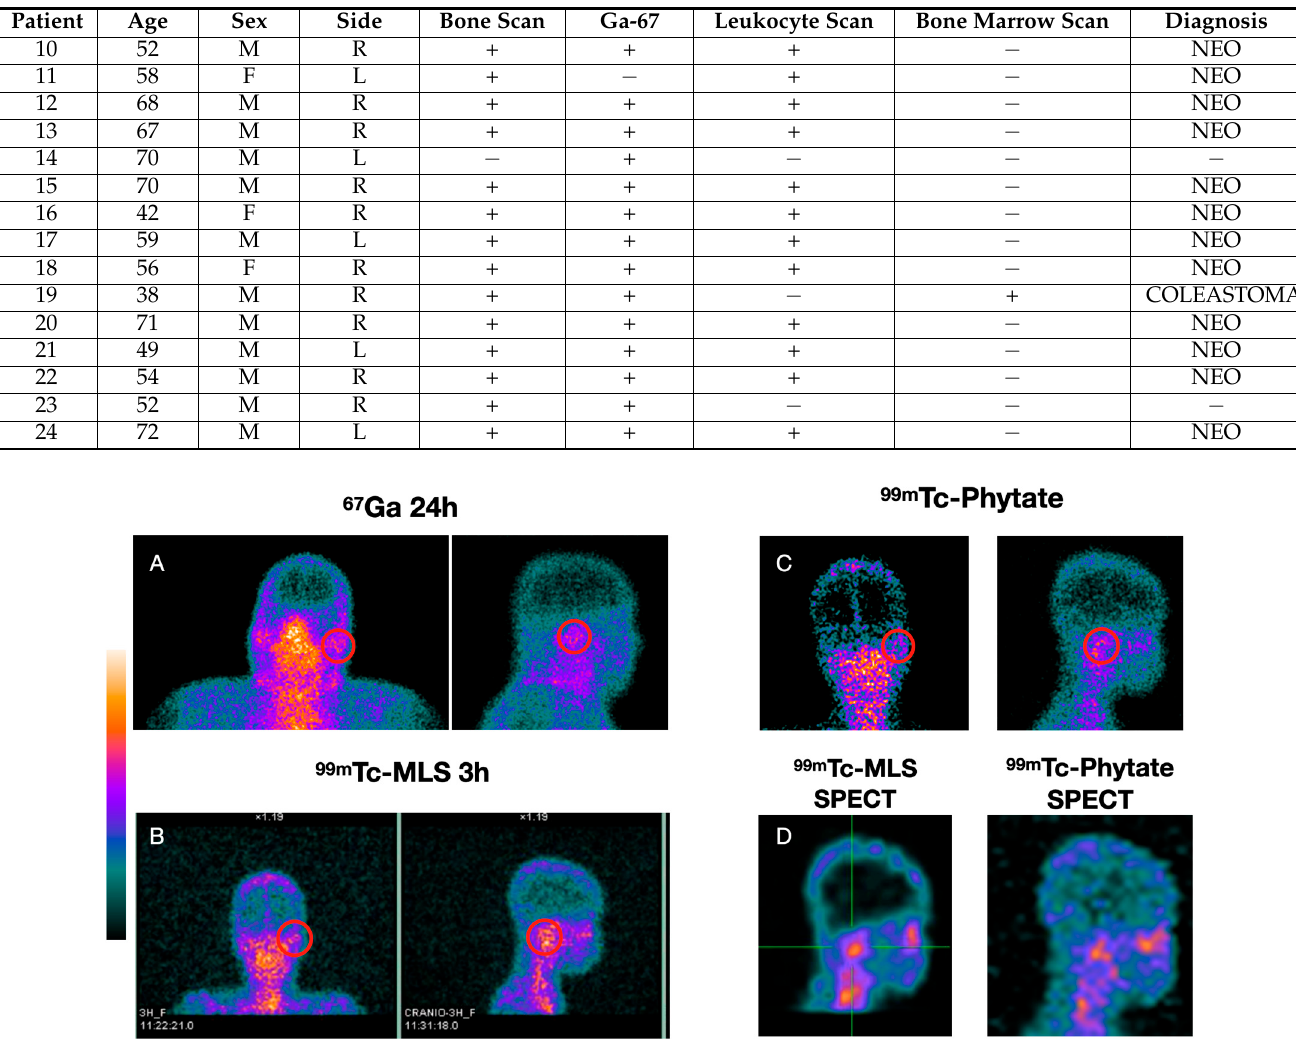
Figure 3. Patient 11. ( A ) Bone 99m Tc-MDP scintigraphy in left mastoid topography (posterior and lateral incidence). ( B ) 67 Ga scintigraphy taken 24 h after radiotracer iv. injection showing higher uptake at the region of interest (ROI, red ring). ( C ) 67 Ga scintigraphy taken 48 h after radiotracer iv. injection showing a long-lasting higher uptake at the ROI. ( D ) 99m Tc-MLS with a higher uptake 3 h after iv. injection of labeled cells. A skin biopsy showed a chronic nonspecific inflammatory process characterized by granulation tissue with recently formed blood capillaries, fibroblasts, and infiltrated leukocytes at the site.